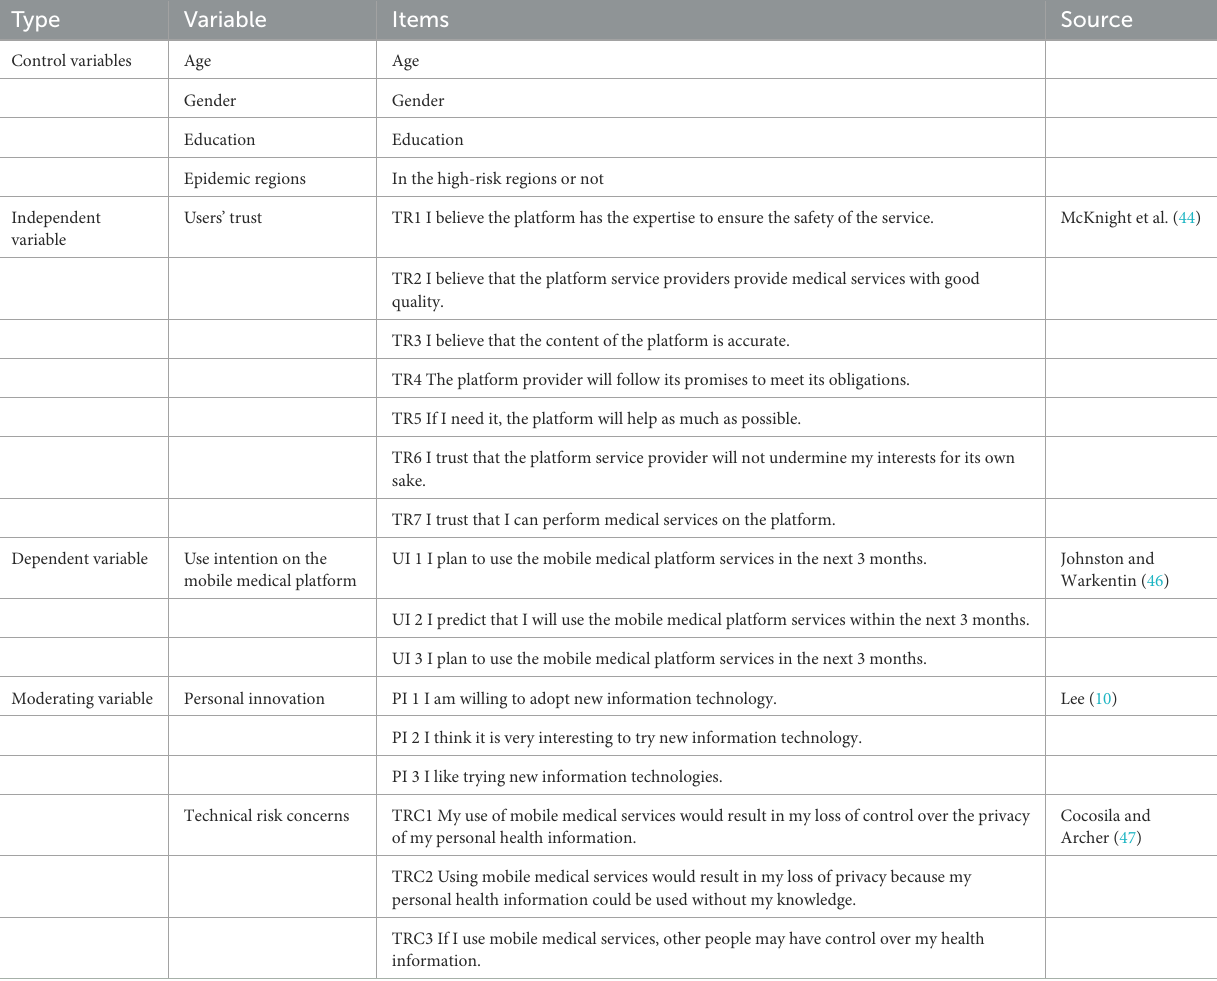
TABLE 1 The detailed information in each